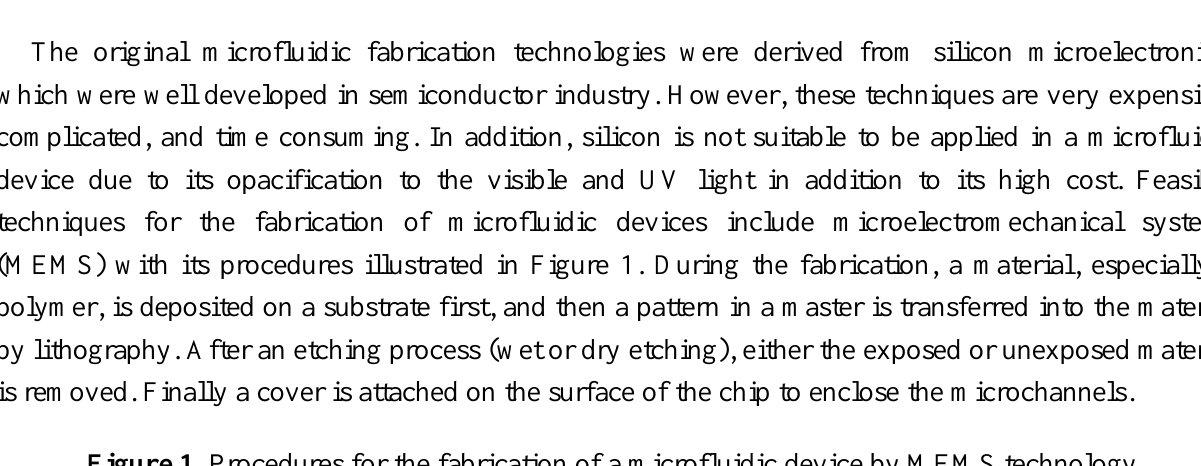
Figure 1. Procedures for the fabrication of a microfluidic device by MEMS